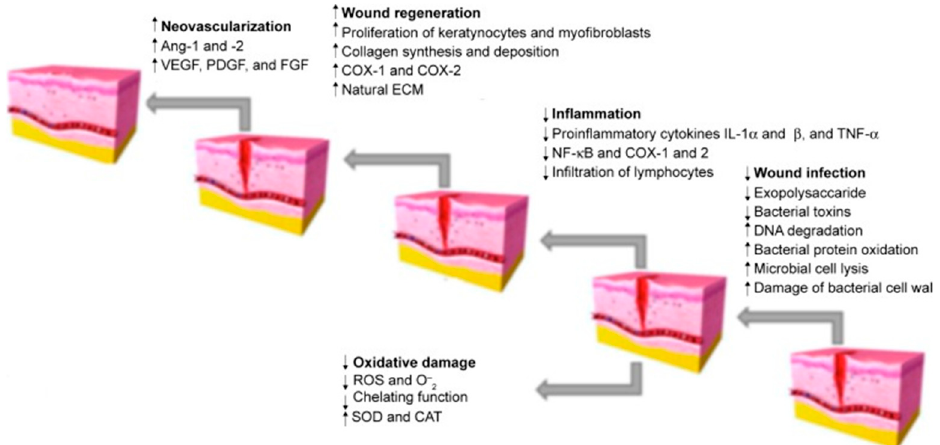
Figure 1. Stages of wound healing. Adapted from Hajialyani, M.; Tewari, D.; Sobarzo-Sánchez, E.; Nabavi, S.M.; Farzaei, M.H.; Abdollahi, M. Natural Product-Based Nanomedicines for Wound Healing Purposes: Therapeutic Targets and Drug Delivery Systems [119].